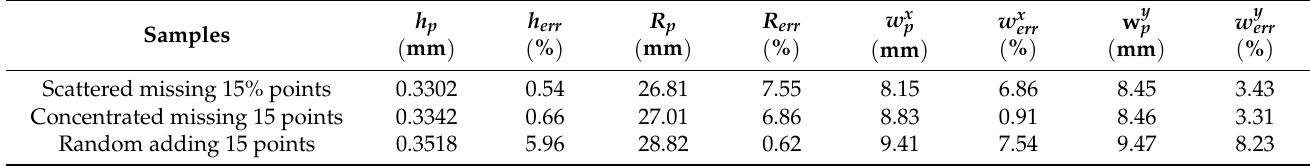
Table 7. The detailed reconstructed surface characteristics of the three